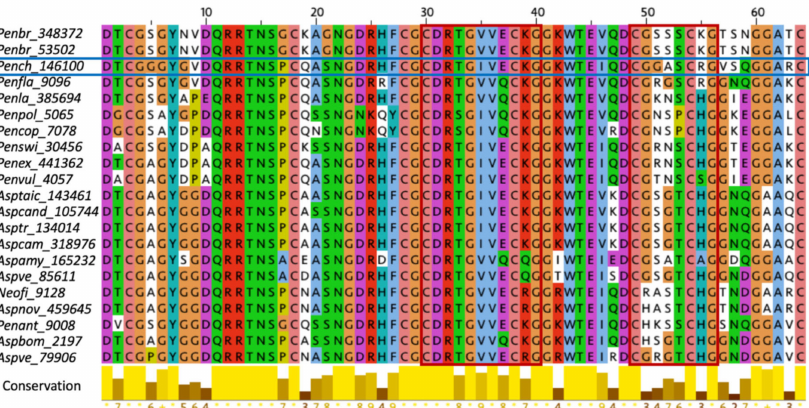
Figure 1. ClustalW multiple alignment of the mature, P. brevicompactum “bubble protein” BP-clade- specific MPs of Eurotiomycetes [21]. P. chrysogenum PAFC (Pench_146100) is framed in blue. The two conserved γ -core motifs found in the members of this clade are framed in red. The abbreviations of the full species names and the protein accession number are indicated: Penbr ( P. brevicompactum ), Pench ( P. chrysogenum ), Penfla ( Penicillium falvigenum ) Penla ( Penicillium lanosocoeruleum ), Penpol ( Peni- cillium polonicum ), Pencop ( Penicillium coprophilum ), Penswi ( Penicillium swiecickii ), Penex ( Penicillium expansum ), Penvul ( Penicillium vulpinum ), Asptaic ( Aspergillus taichungensis ), Aspcand ( Aspergillus can- didus ), Asptr ( Aspergillus triticus ), Aspcam ( Aspergillus campestris ), Aspeamy (Aspergillus amylovorus), Aspve ( Aspergillus versicolor ), Neofi ( Neosartorya fischeri ), Aspnov ( Aspergillus novofumigatus ), Penant ( Penicillium antarticum ), and Aspbom ( Aspergillus bombycis ). The color coding of aa was applied according to ClustalX. The conservation between the respective sequences based on the ClustalW2 Multiple Sequence Alignment tool [26] is indicated at the